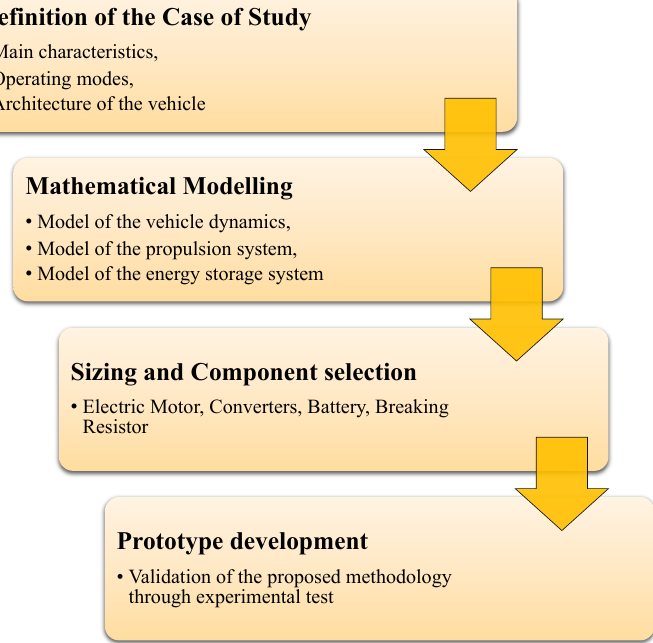
Figure 1. A general overview of the methodology and design procedure for the electrification of a maintenance railway